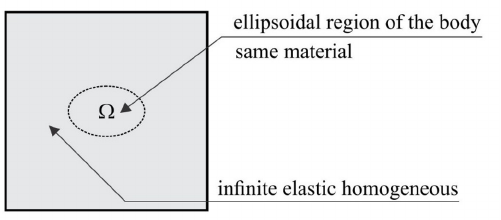
Figure 2: Esheby's inclusion problem